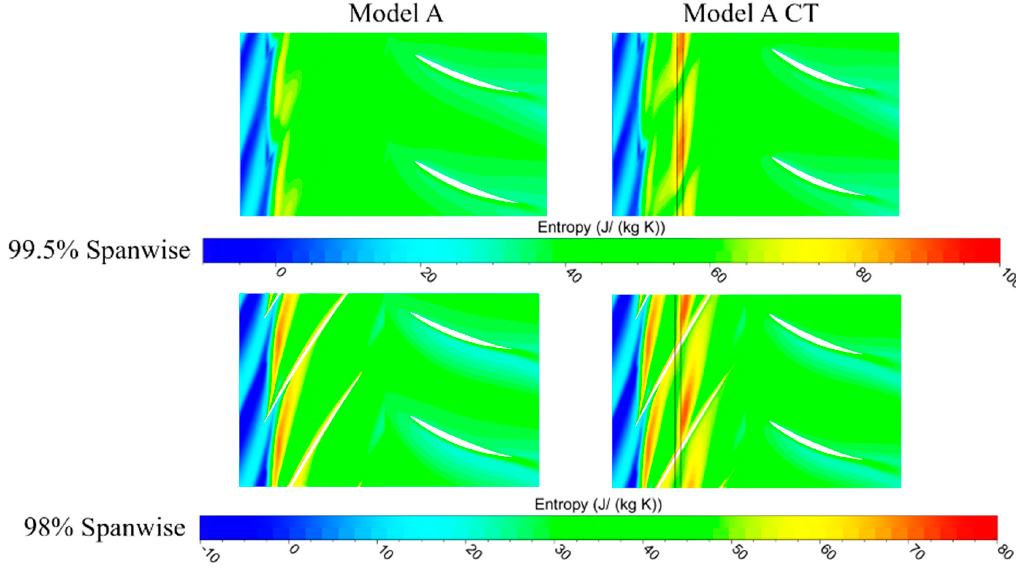
Figure 17. Entropy distributions at 99.5% and 98% spanwise.